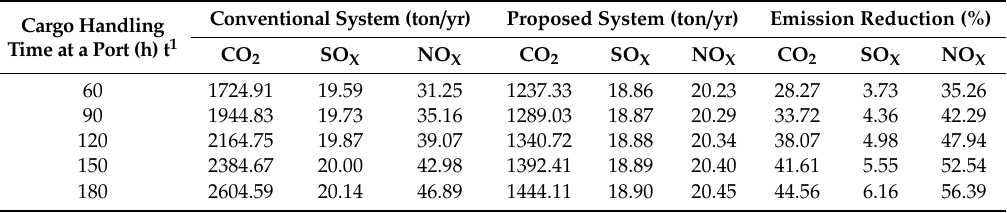
Table 16. Comparison of emissions according to di ff erent cargo handling